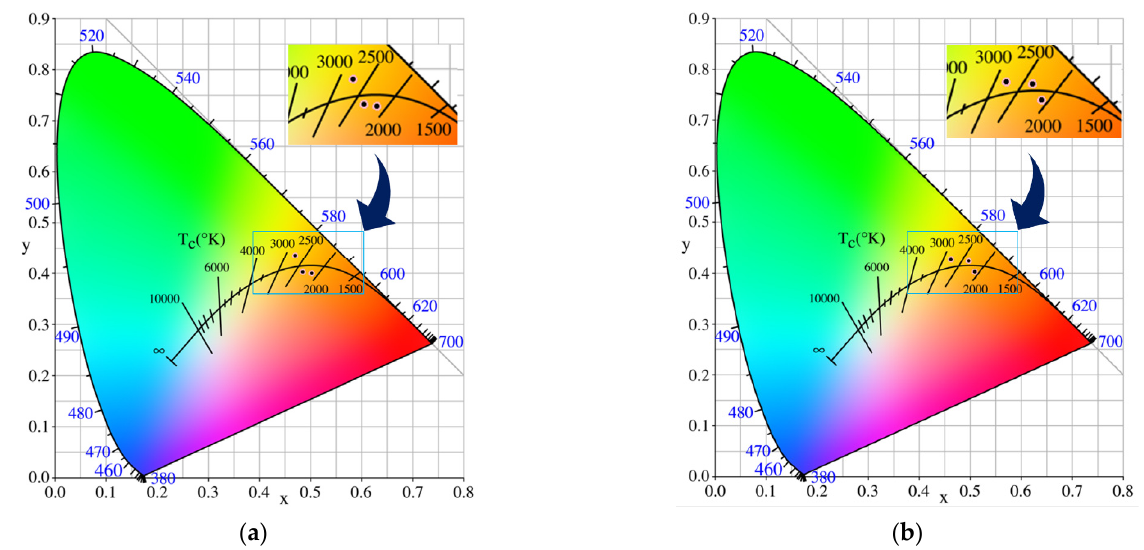
Figure 6. Chromaticity coordinate: ( a ) 175-mm filament; ( b ) 255-mm filament.